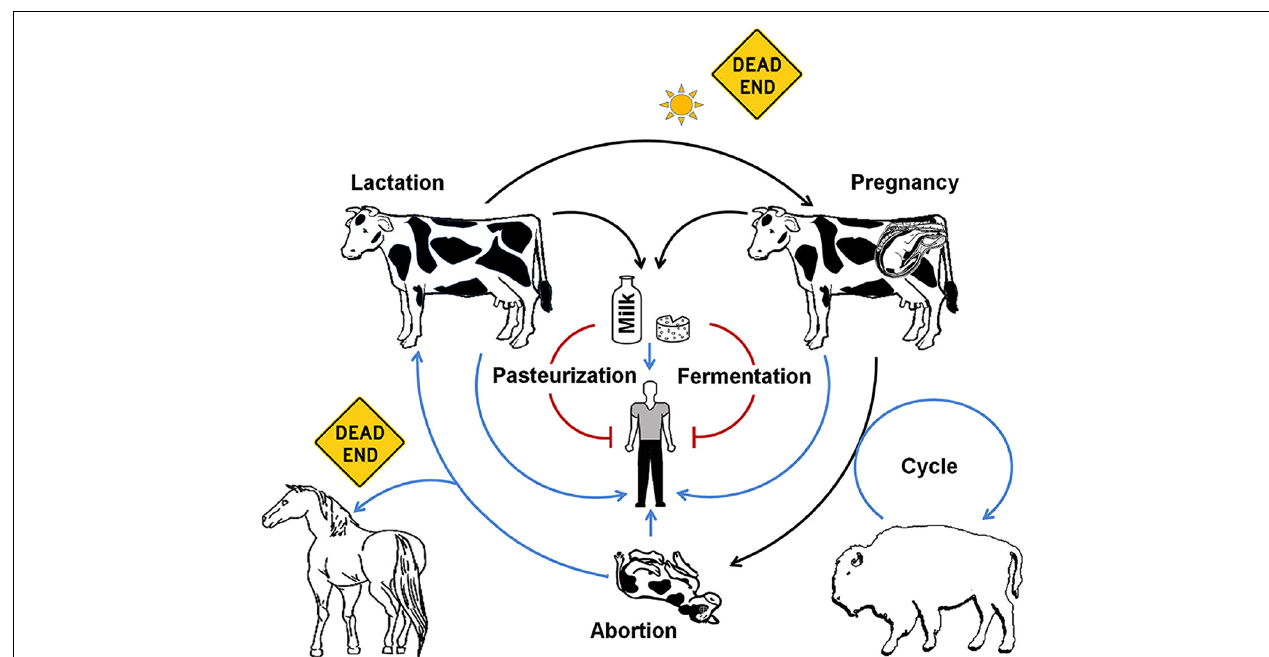
organic material is available and the bacterium is protected from the sun’s rays. When exposed to sun’s rays in the open, Brucella organisms steadily die (doted black arrow). Pasteurization or fermentation of dairy products eliminates Brucella organisms and the risk of human contamination (red blunt arrows). Cross contamination of wild life animals (e.g., bison at lower right) may maintain the bacteria cycling within wild herds, and then of epidemiological relevance. Humans and other animals (e.g., horses) are considered dead ends for the bacterium, and therefore there are not of epidemiological